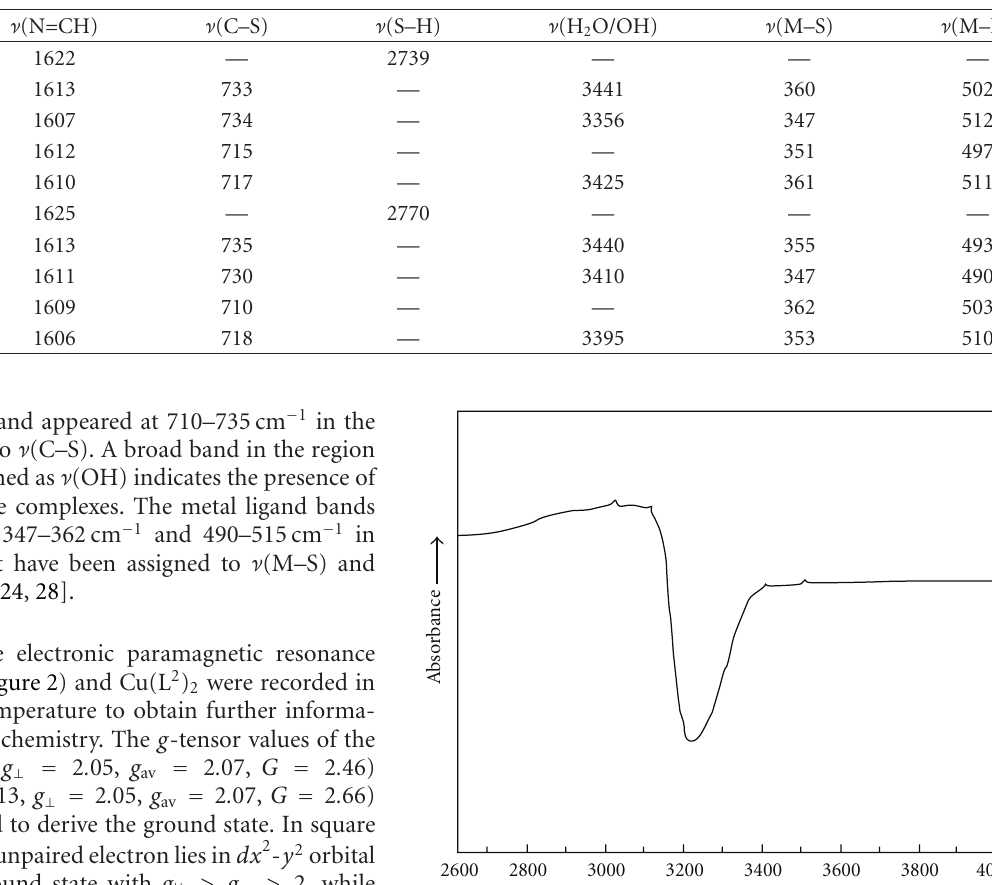
Table 2: Important IR spectral bands (cm − 1 ) of Schi ff bases and their metal complexes.